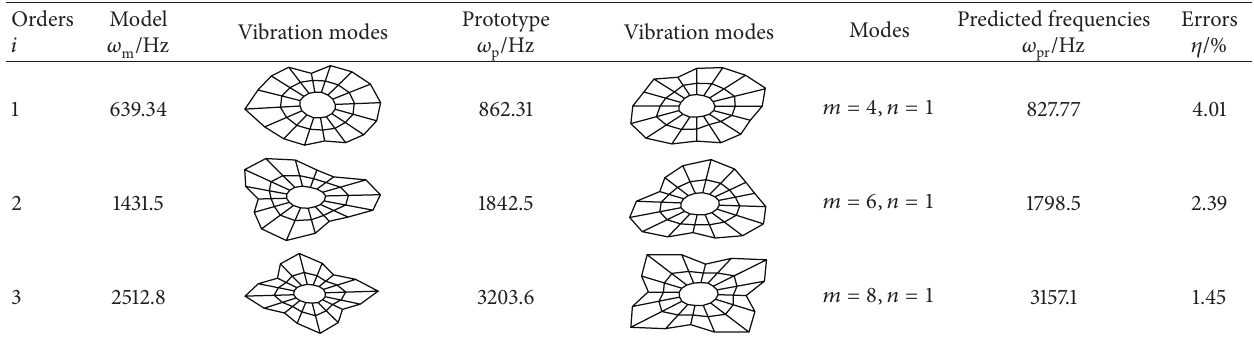
Table 8: The comparison of experimental and predicted